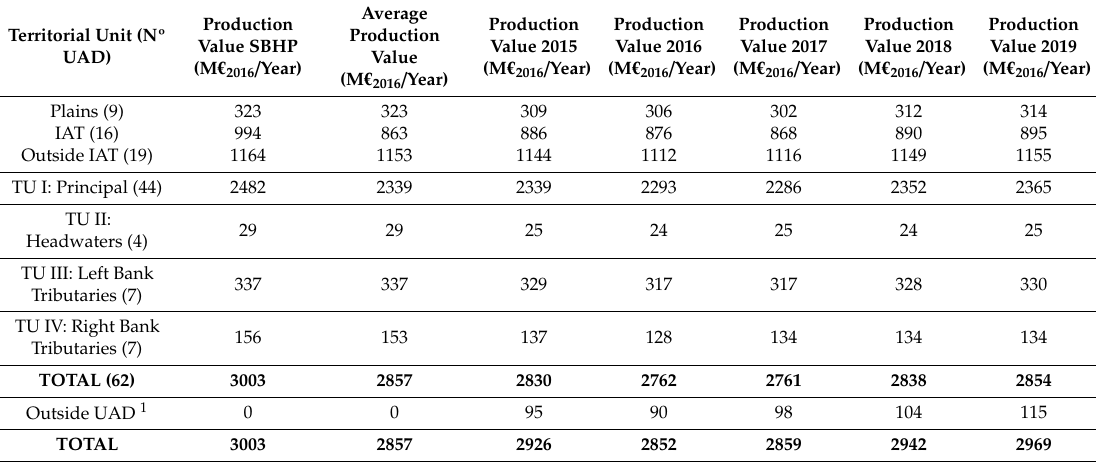
Table 9. Evolution of the value of production 2015–2019 Source: HPO. Own elaboration.